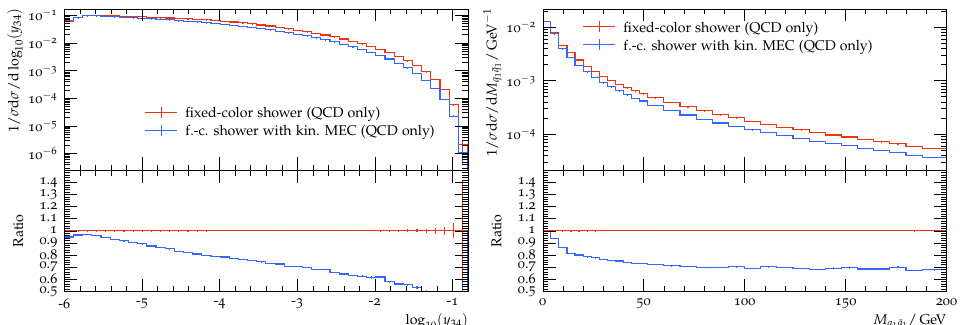
Figure 7: Effect of kinematic matrix element corrections on the qq ¯ q ¯ q state for QCD evolution and correction only. The left plot shows the 4 → 3 Durham jet clustering scale, while the right plot shows the invariant mass of the pair of energetically softer quark and anti-quark. We see a large effect of up to 50% for very high jet masses.